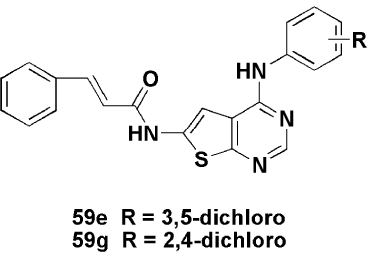
Figure 15. Structure of compounds 59e and 59g [48].